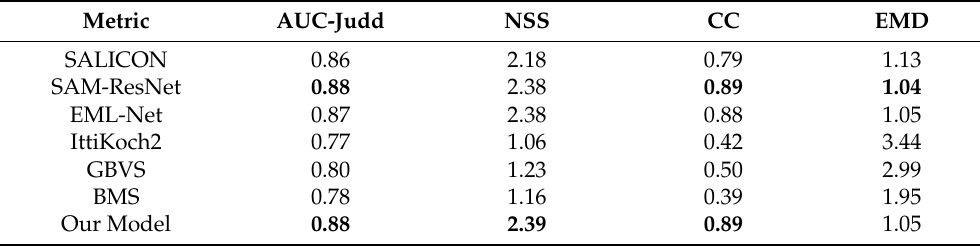
Table 1. Quantitative results of evaluation measures on the Cat2000 validation dataset. Metric AUC-Judd NSS CC SALICON